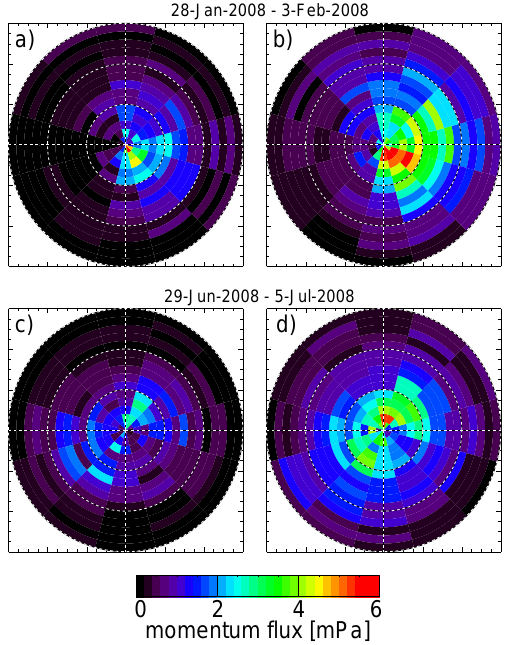
Figure 7. Momentum flux [mPa] vs. phase speed (distance from Fig. 7. Momentum flux [mPa] vs. phase speed (distance from center, [ ms − 1 ]) and azimuthal direction (east- center, [ms − 1 ]) and azimuthal direction (eastward, positive x ; ward, positive x; northward, positive y). The left column (panels a, c) shows cases for which backtraces northward, positive y ). The left column (a, c) shows cases for which naturally end at convection, i.e. intersection of rays with convection is not taken into account. The right column backtraces naturally end at convection, i.e., intersection of rays with (panels b, d) shows all other cases. The upper row (panels a, b) gives spectra for the period 28 January 2008 to convection is not taken into account. The right column (b, d) shows 3 February 2008, the lower row (panels c, d) gives spectra for the period 29 June 2008 to 5 July 2008. Black all other cases. The upper row (a, b) gives spectra for the period 28 January 2008 to 3 February 2008, the lower row (c, d) gives spectra and white dashed concentric circles indicate 20, 40 and 60 ms − 1 phase speed. for the period 29 June 2008 to 5 July 2008. Black and white dashed concentric circles indicate 20, 40 and 60ms − 1 phase